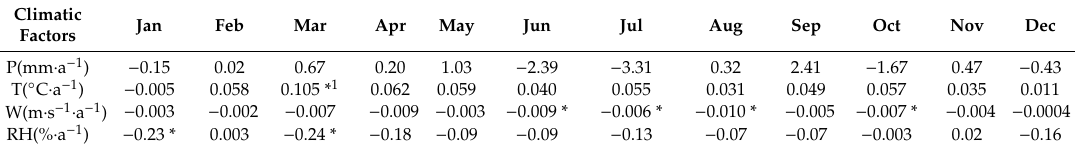
Figure 3. The variation trend of annual climatic factors from 1993 to 2013. Table 2. The inter-annual variation trend of monthly climatic factors from 1993 to 2013.